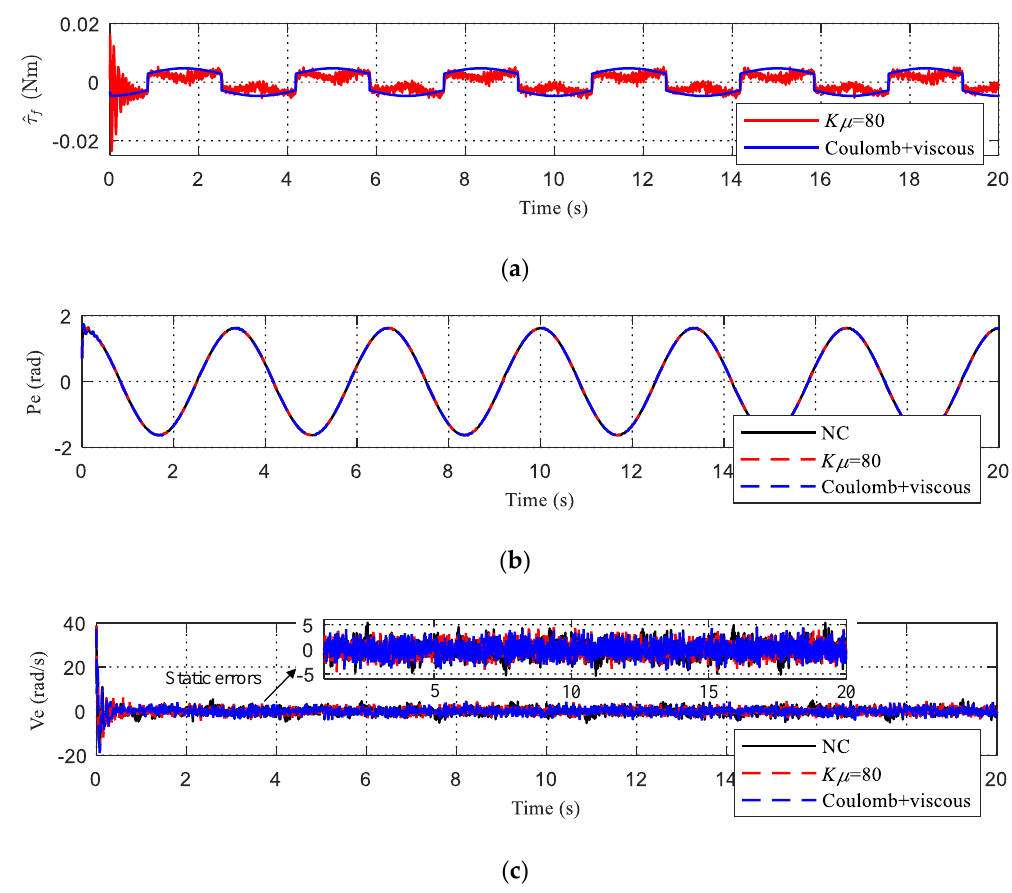
Figure 14. Motor low-velocity with payload experiment results. ( a ) Observed total friction torque (red curve) obtained by the proposed method mapped to the motor-side and estimated motor-side friction torque by the Coulomb and viscous friction model at low velocities. ( b ) Motor position tracking errors at low velocities. ( c ) Motor velocity tracking errors at low velocities.